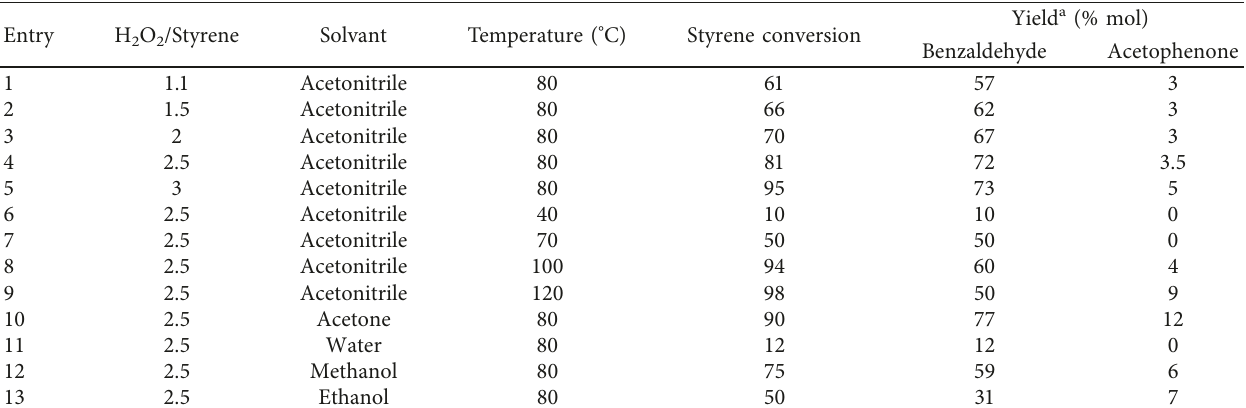
Table 3: Effect of styrene, H 2 O 2 molar ratio, temperature, and